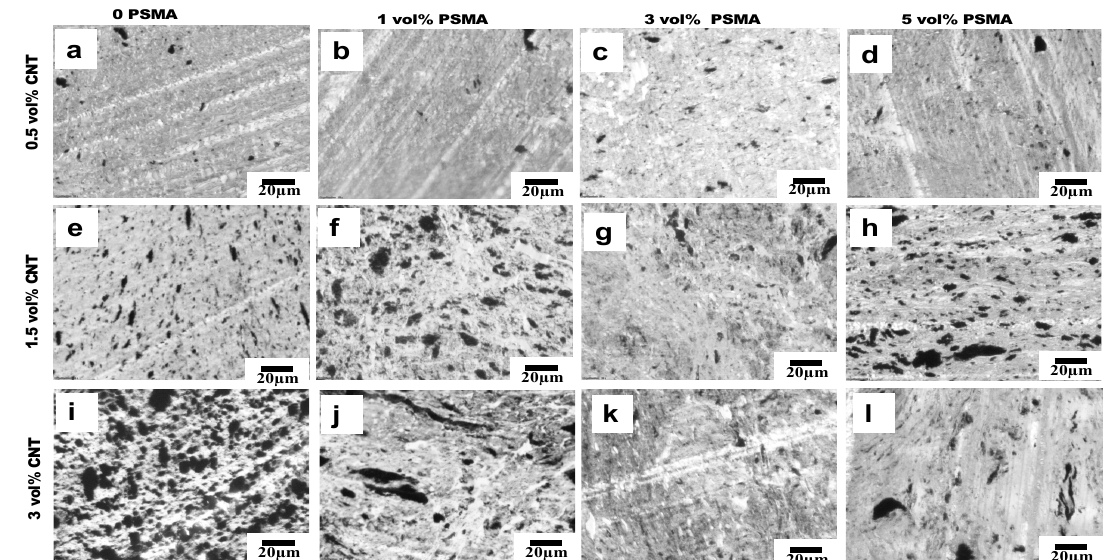
Figure 8. Mixing Order III. ( a – l ) Optical micrographs of PS-PSMA/aPA/CNT polymer blend nanocomposites. Going from left to right, the PSMA concentration in the blend increases and going from top to bottom, the CNT concentration in the PBN increases. Figure 8a,e,i are the same as Figure 7a,e,i because without any PSMA, MO-II and MO-III are identical.